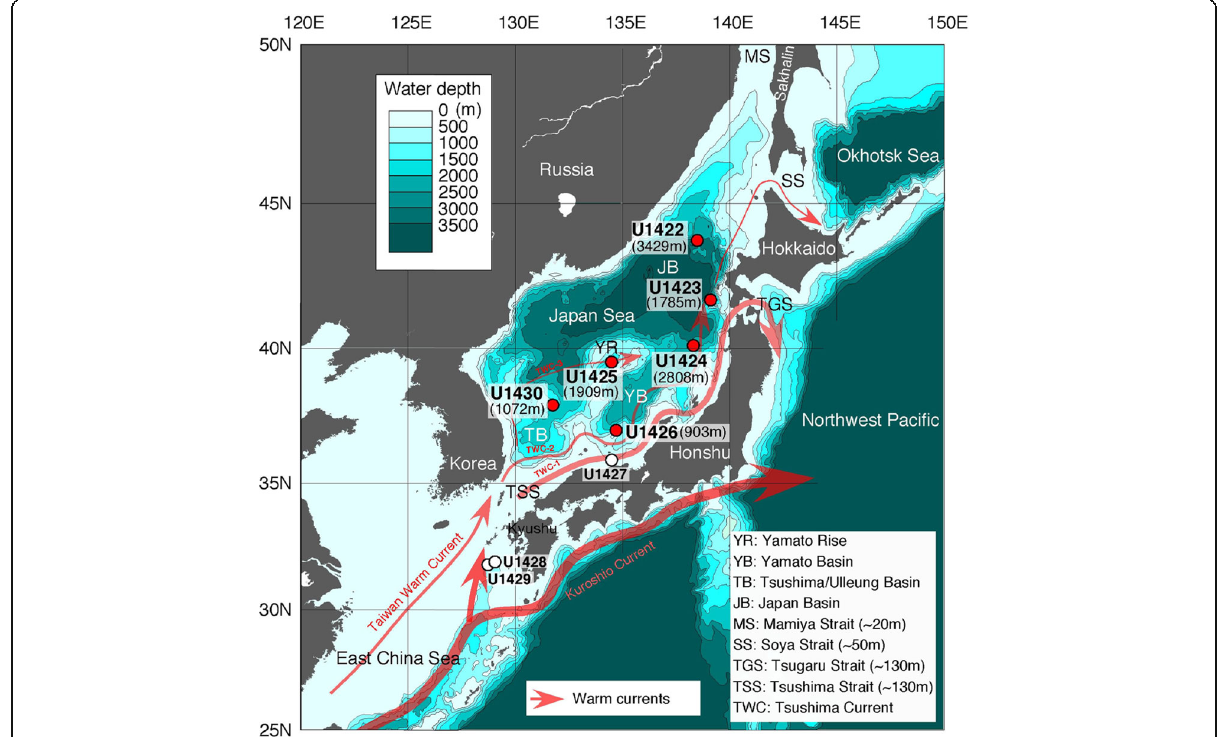
Fig. 1 A map showing locations of studied sites (red circles) together with unstudied sites (white circles) drilled during IODP Expedition 346 in the Japan Sea and northern East China Sea. Surface currents within the sea, water depths of each sites, and sill depths of each straits are also